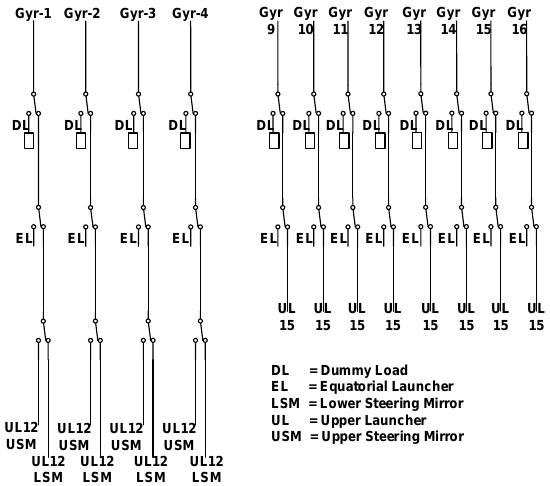
Fig. 3. Transmission Lines inline switches configuration for UL in Port12 and UL in